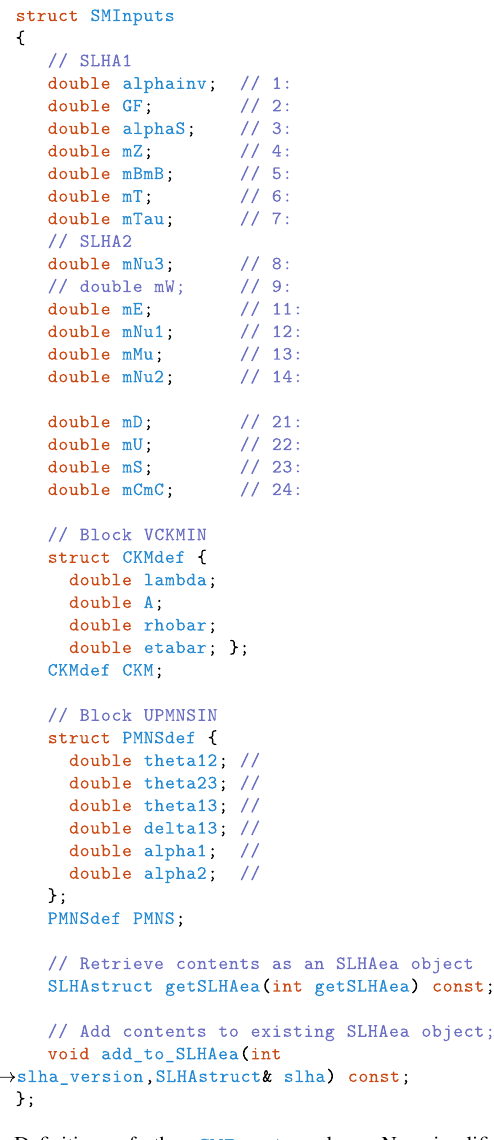
Fig. 7 Definition of the SMInputs class. No simplification has been performed; this is the full class definition as found in Elements/include/gambit/Elements/sminputs.hpp (with condensed